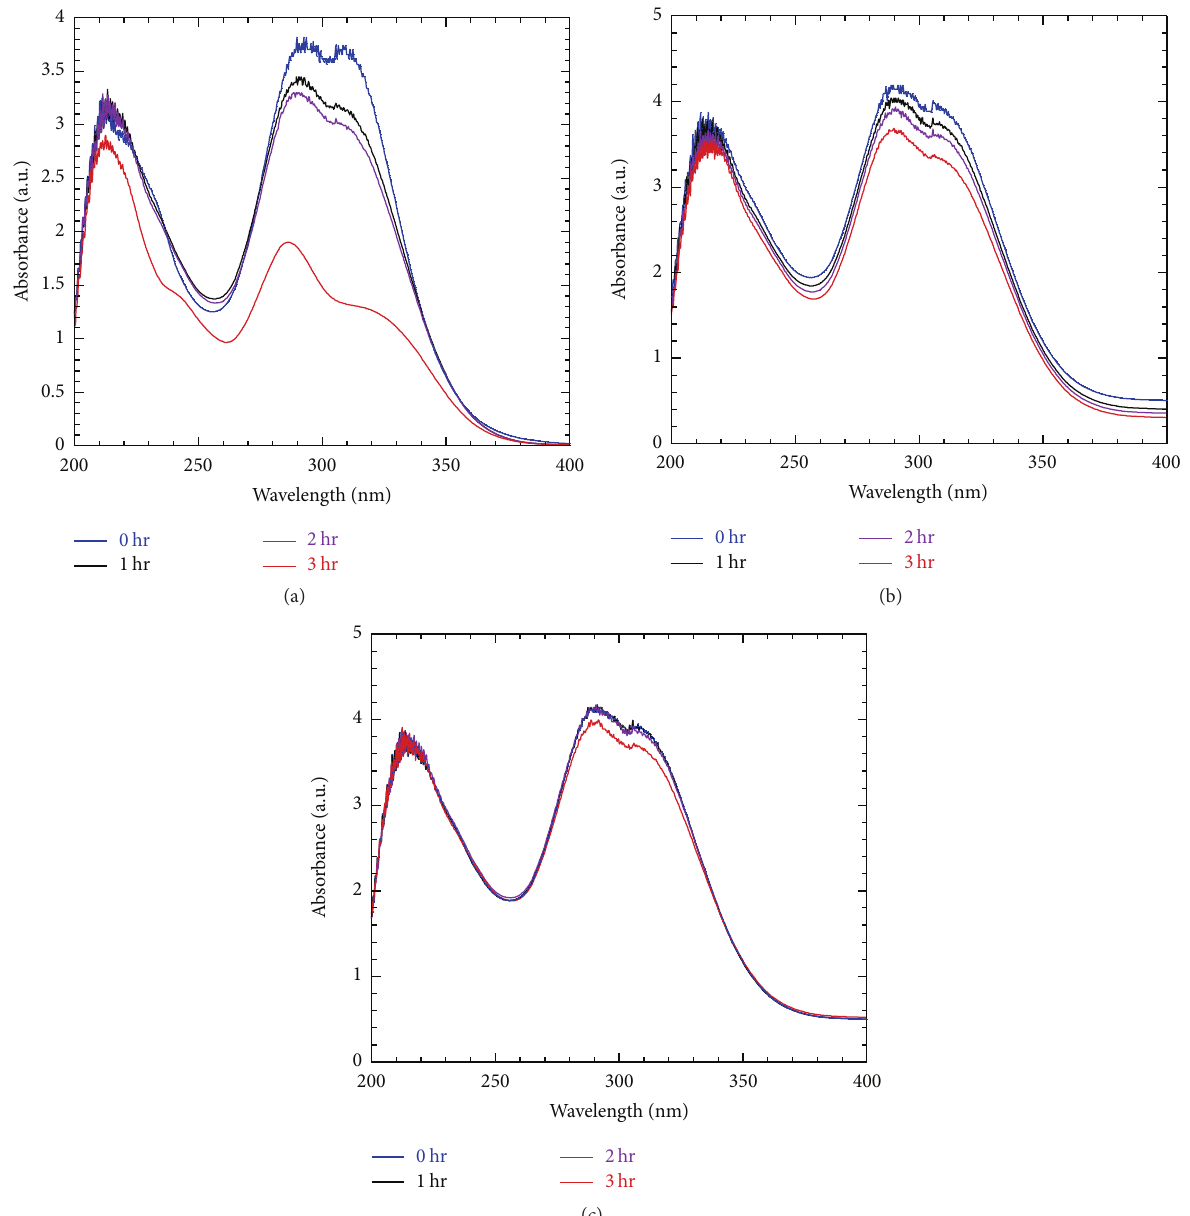
Figure 11: Change in absorption spectra of cream sample after different times of irradiation in the absence and presence of 𝛽 -CD. Irradiation time: 0, 1, 2, and 3 hours. (a) Free of 𝛽 -CD; (b) 5 g 𝛽 -CD; (c) 10g 𝛽